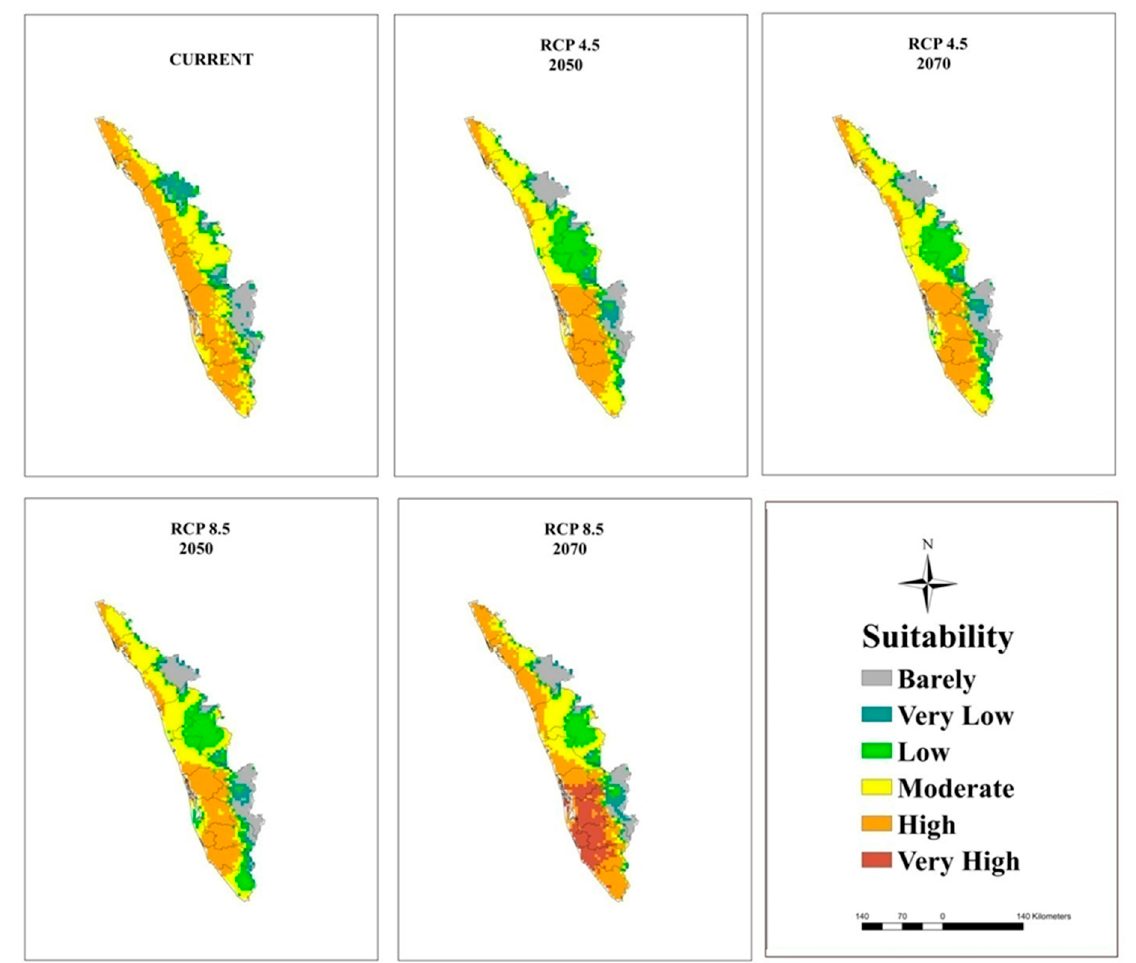
Figure 7. Climatically suitable areas for coconut production in Kerala under the current and future climates of the 2050s and 2070s for RCP 4.5 and RCP 8.5 as modeled by MaxEnt.